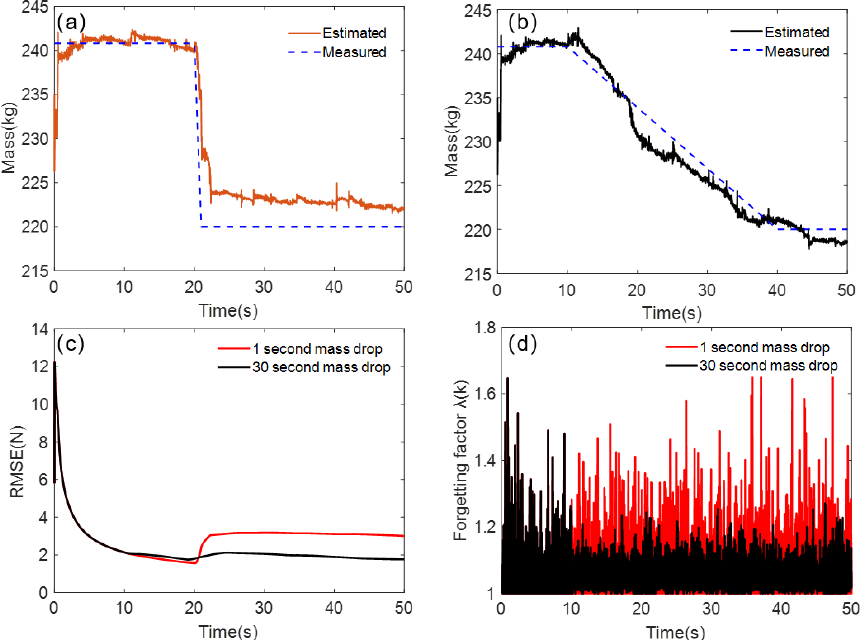
Figure 8. Simulation result of vehicle estimation ( a ) estimated vehicle mass (240 kg → 220 kg from 20 to 21 s), ( b ) estimated vehicle mass (240 kg → 220 kg from 10 to 40 s), ( c ) RMSE according to mass drop rate, ( d ) forgetting factor according to mass drop